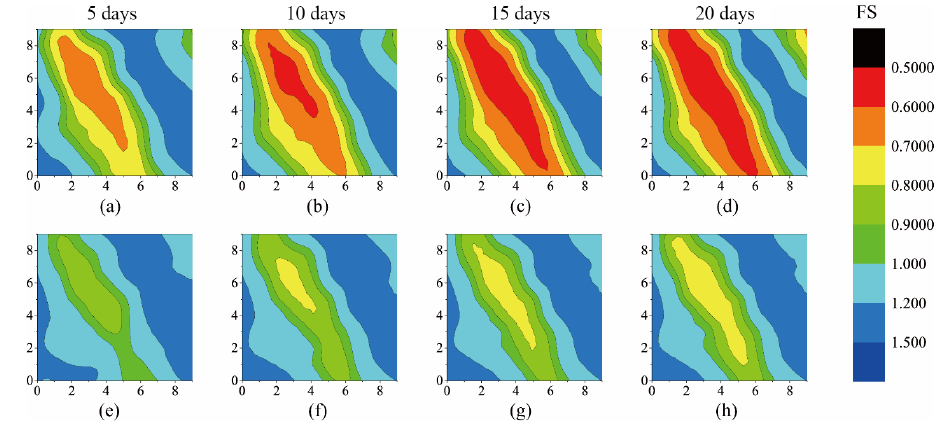
Figure 5. Model results and assimilation results of FS. The maps in the first row are the model running for 5, 10, 15 and 20 days, and those in the second row are the assimilation results. The horizontal and vertical coordinates in each graph are the grid numbers of each cell.